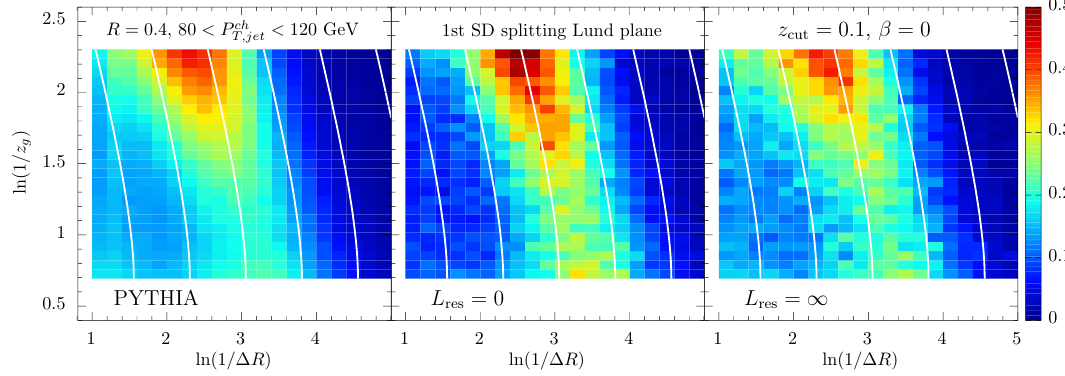
Figure 4 . The Lund plane de(cid:12)ned by the (cid:12)rst pair of subjets found via the Soft Drop procedure that pass the Soft Drop condition (4.1). The three panels show this Lund plane for jets in vacuum as described by PYTHIA, and for jets in a medium with L res = 0 (middle panel) and L res = 1 (right p panel) as described by the hybrid model at s = 2 : 76 ATeV. Color indicates the density in the (log(1 =z g ) ; log(1 = (cid:1) R )) plane corresponding to the probability of (cid:12)nding such subjets with a given z g and (cid:1) R . We have used the (cid:13)at grooming procedure ( (cid:12) = 0 and z cut = 0 : 1) and the distributions are normalized to the total number of analyzed jets, N jets , within the cuts 80 < P ch < 120 GeV T; jet and j (cid:17) j < 0 : 9. The jets were reconstructed with anti- k t radius R = 0 : 4. White curves correspond to contours of constant log(1/( M g =p T;g )), where M g is the groomed mass and p T;g is the groomed transverse momentum of the